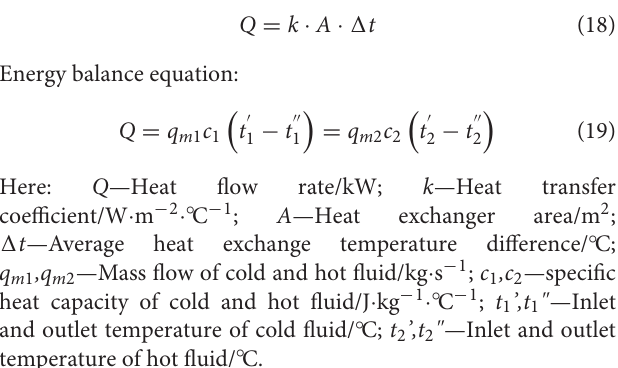
TABLE 2 | 100 kW BG-SOFC-CHP system